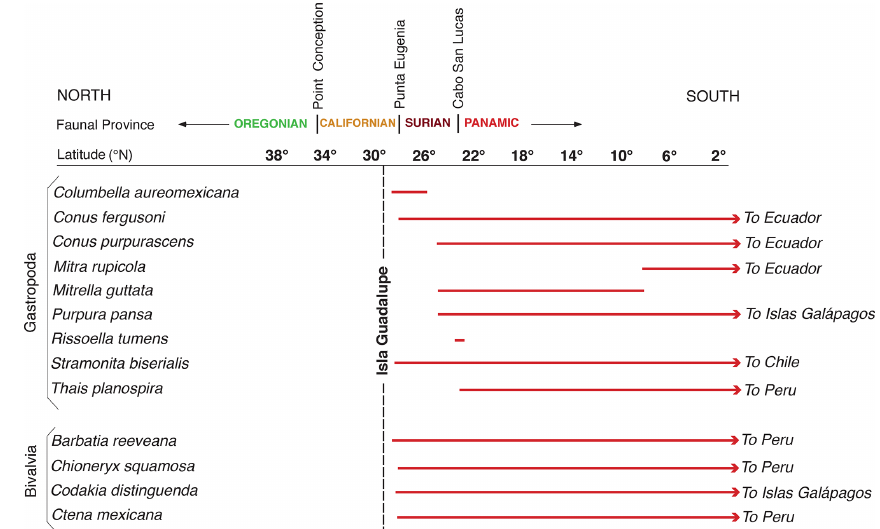
Figure 44. Extralimital southern species of gastropods and bivalves (from Lindberg et al., 1980) in marine deposits of Isla Guadalupe, Mexico (see Fig. 42 for location), dated to MIS 5e by Muhs et al. (2002a), as well as their modern latitudinal distribution (from Keen, 1971, for gastropods; from Coan and Valentich-Scott, 2012, for bivalves). Note also that the deposits also contain the extralimital southern genus of coral Pocillopora (see Fig. 42) and the Indo-Pacific gastropod Naria cernica (see text for